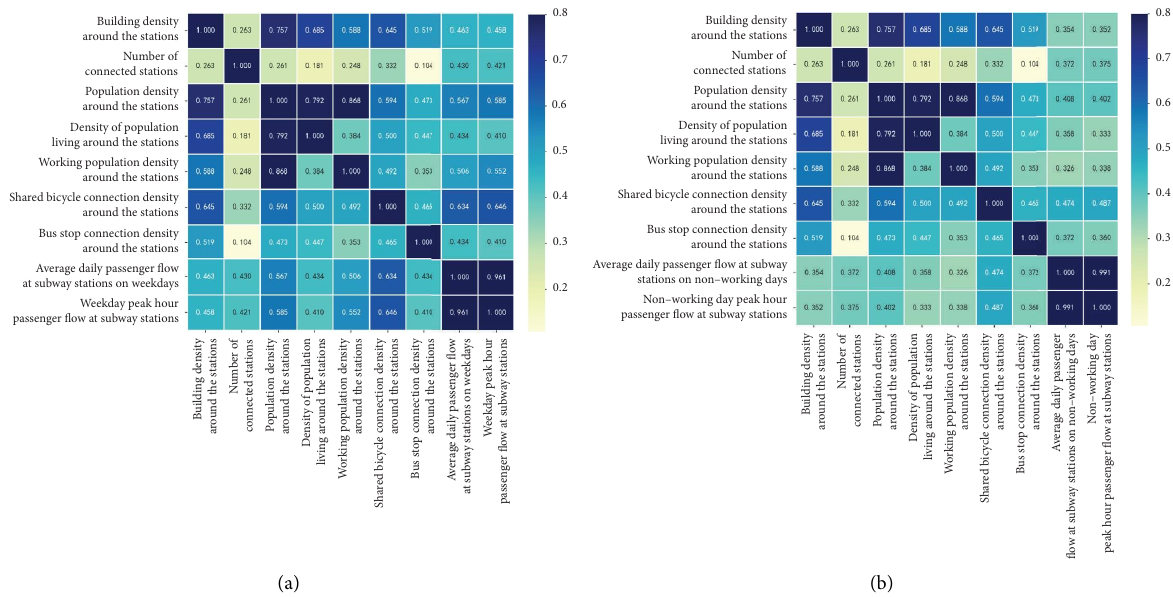
Figure 16: Pearson correlation coefcient analysis of each index and average daily passenger fow. (a) Weekdays; (b) nonworking days. Table 5: Model training accuracy analysis—average daily passenger fow. Working days Nonworking days